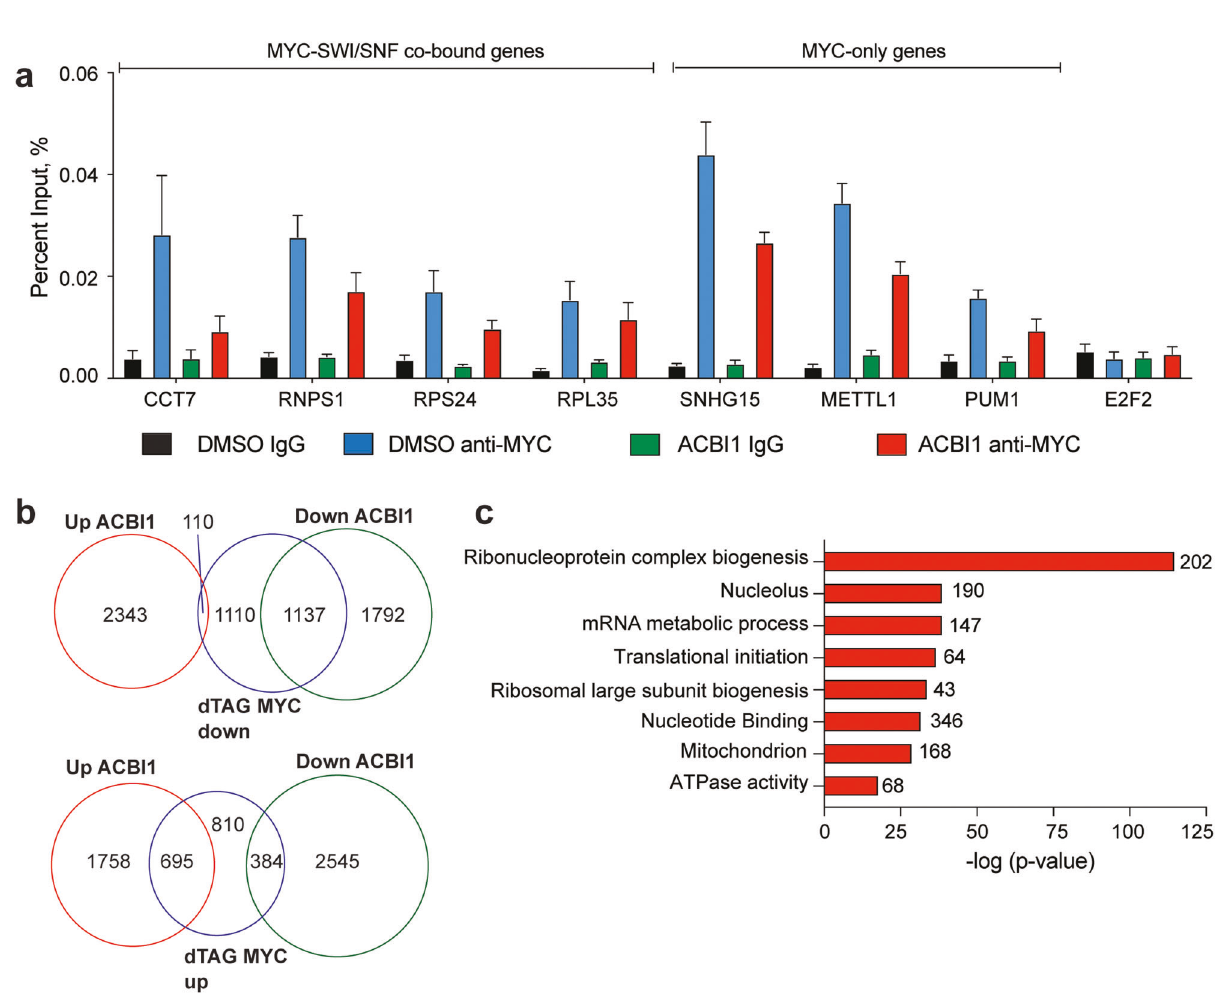
Fig. 4 Removal of BRG1 compared to removal of MYC. a Chromatin immunoprecipitation followed by QPCR for various MYC-bound loci after ACBI1 treatment for 24 h. E2F2 serves as a negative control for binding ( n = 4 biological replicates, error bars are standard error). b Venn diagram comparing all signi fi cant transcript changes that result from ACBI1 treatment to decreased (top) or increased (bottom) gene expression changes that occur after removal of MYC using the dTAG approach [15]. c GO analysis of 1137 genes that are commonly decreased in expression across dTAG MYC and ACBI1 samples. Number of genes in each term are shown next to the bar.